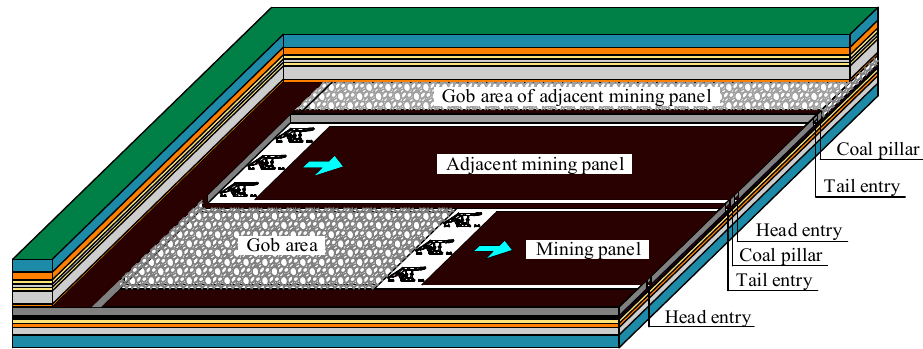
Figure 1. Schematic diagram of the coal pillar retaining roadways.